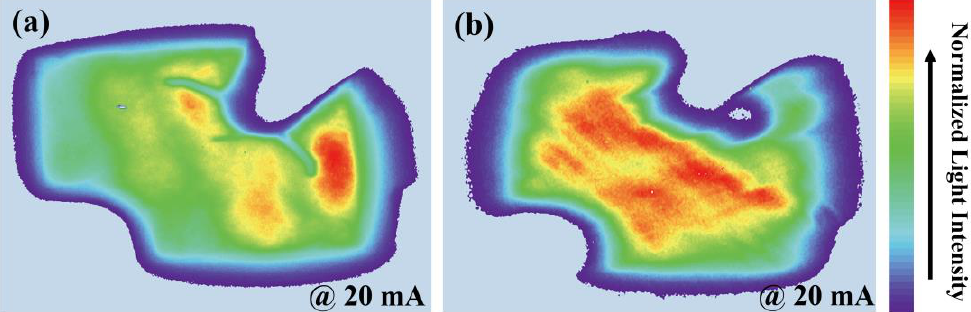
Figure 5. The normalized light emission intensity distribution images of ( a ) Device S 0 and ( b ) Device S 1 at 20mA.